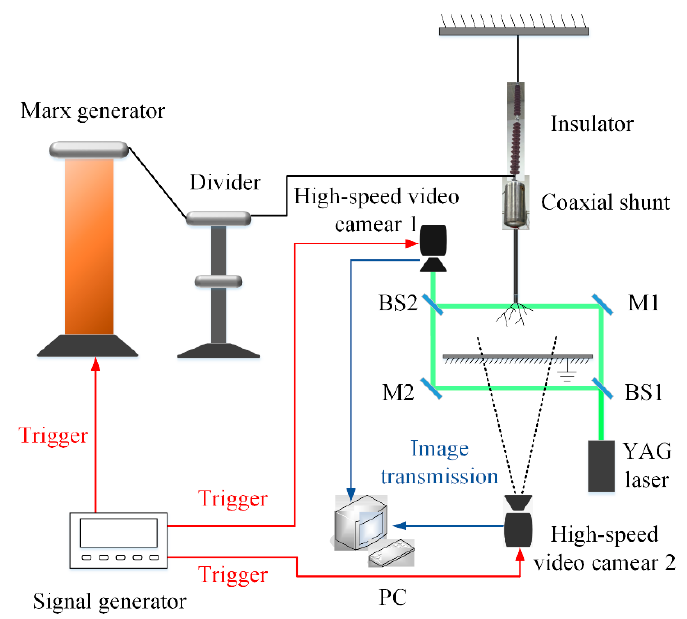
Figure 4. Diagram of the experimental setup.